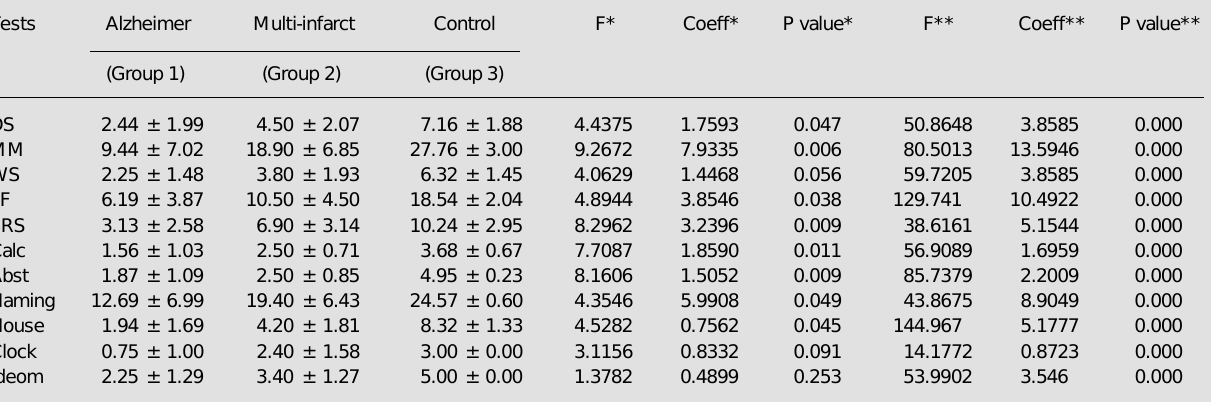
Table 4 - Results of the neuropsychological evaluation (Alzheimer, multiinfarct and normal volunteers) reported as mean ± standard deviation (controlled for age and years of education) (MANOVA F-values, coefficients of the two-level factor comparison, and P value). Coeff = Coefficient; DS = digit span; MM = Mini-Mental; WS = word span; FF = famous faces; SRS = spatial recognition span; Calc = calculation; Abst = abstraction; Ideom = ideomotor. *Comparison between Alzheimer and multiinfarct patients; **comparison between dementia (Alzheimer and multiinfarct together) and normal